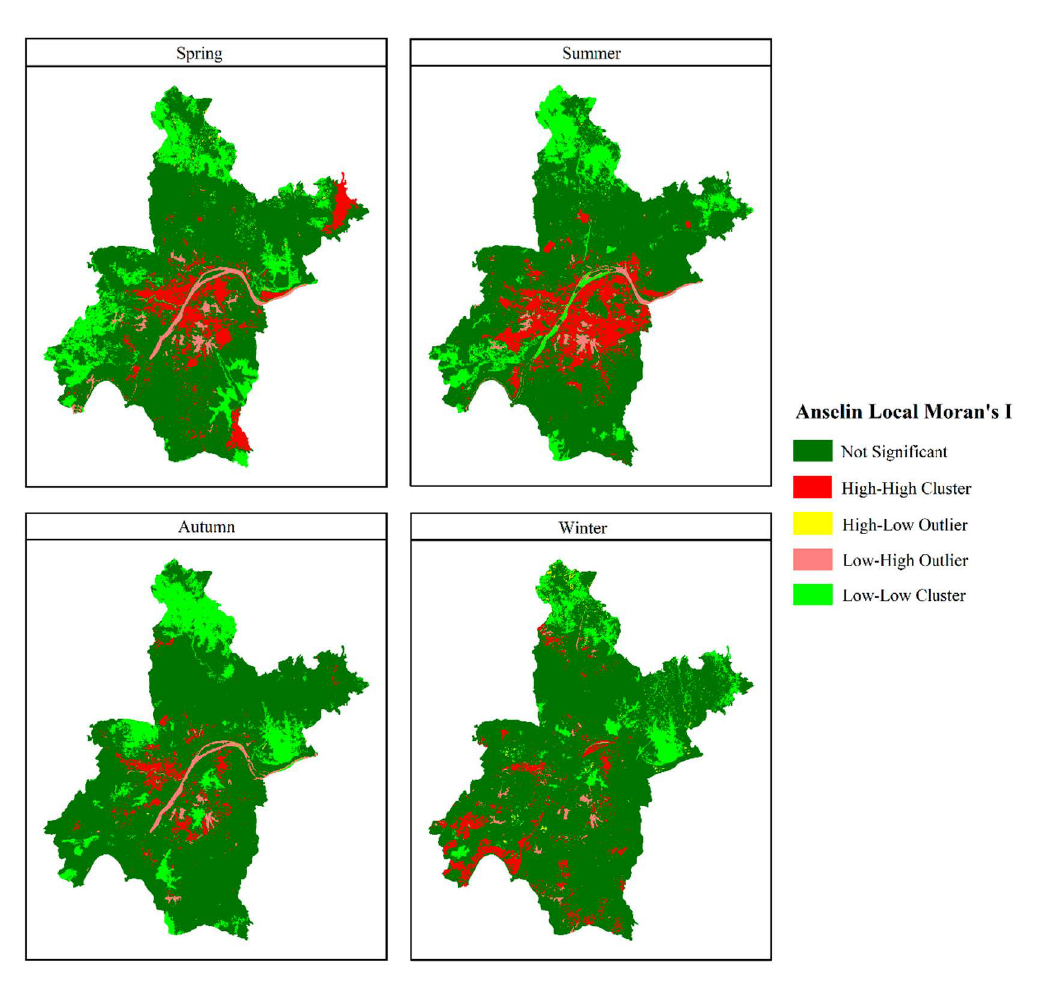
Figure 5. LST clustering features based on local spatial correlation